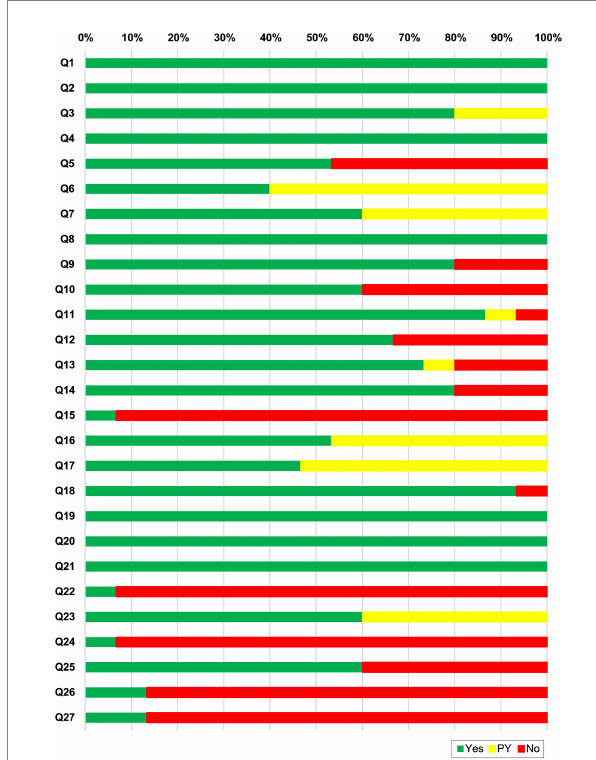
FIGURE 3 PRISMA 2020 checklist results for each item. Q1. Title; Q2. Abstract; Q3. Rationale; Q4. Objectives; Q5. Eligibility criteria; Q6. Information sources; Q7. Search strategy; Q8. Selection process; Q9.